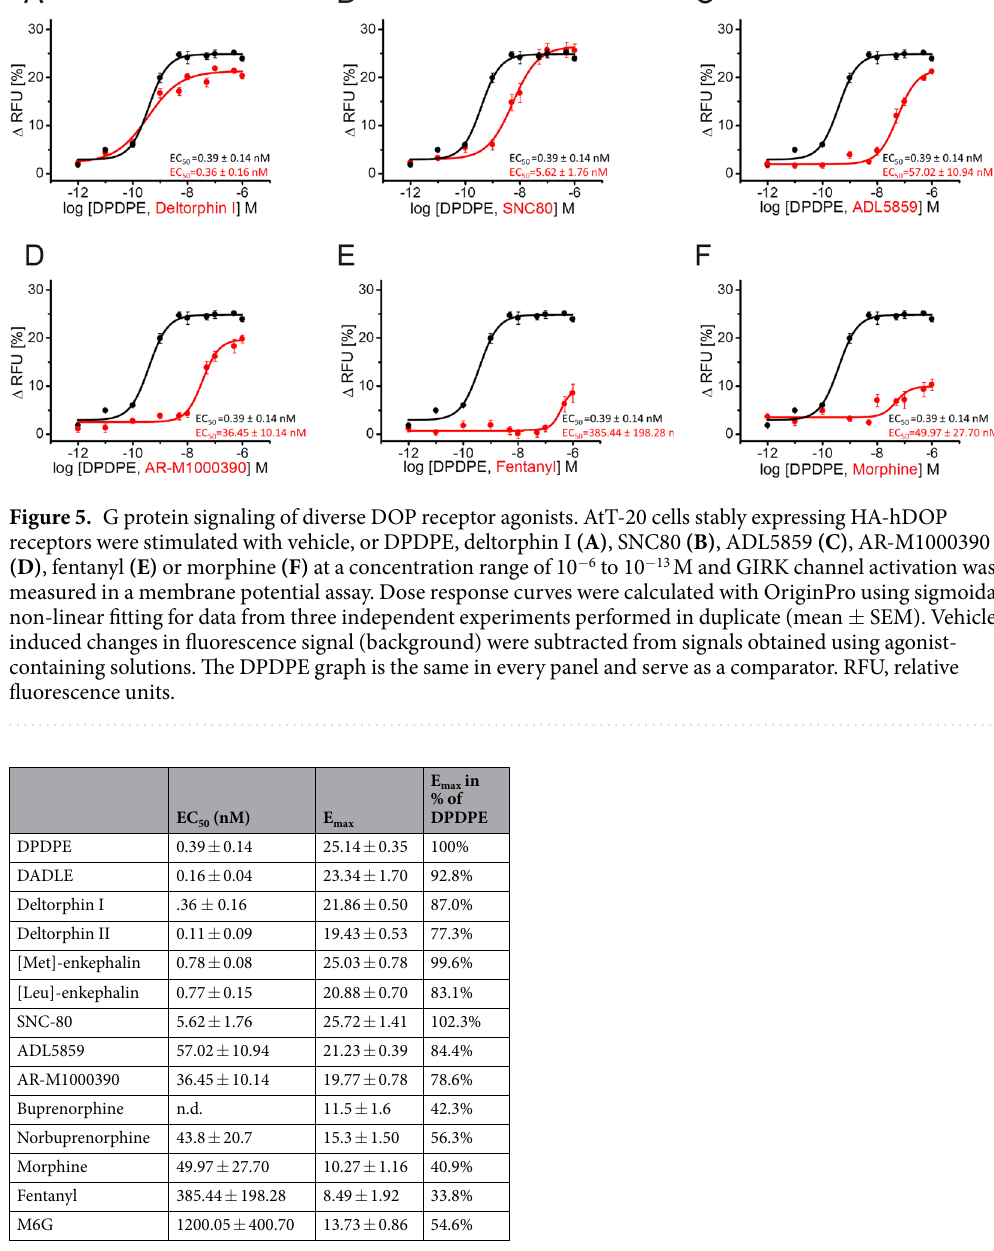
Table 1. G protein signaling of diverse DOP receptor agonists. n.d. not